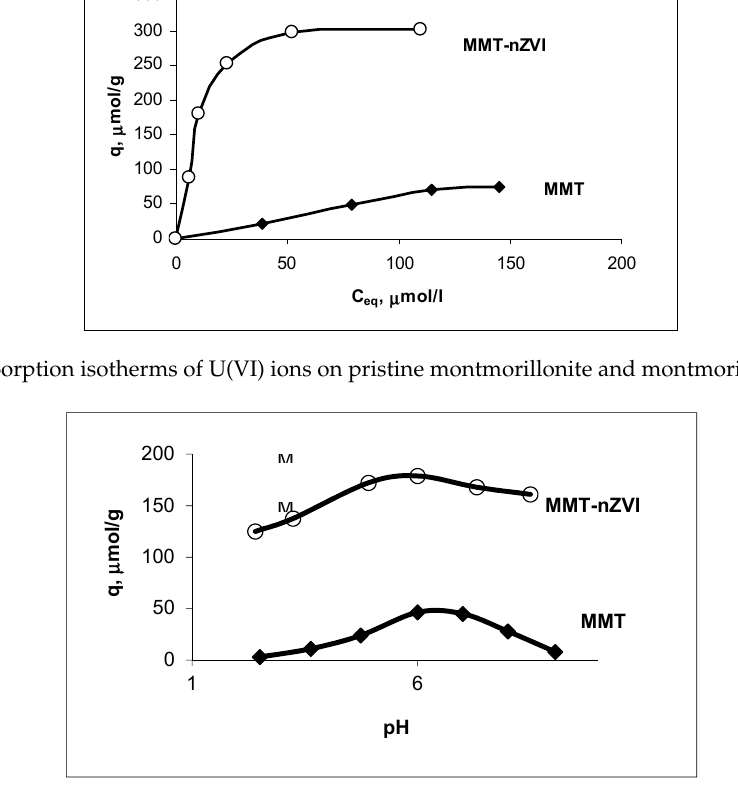
Figure 6. Sorption of U(VI) ions on pristine montmorillonite and montmorillonite-nZVI as a function of pH.